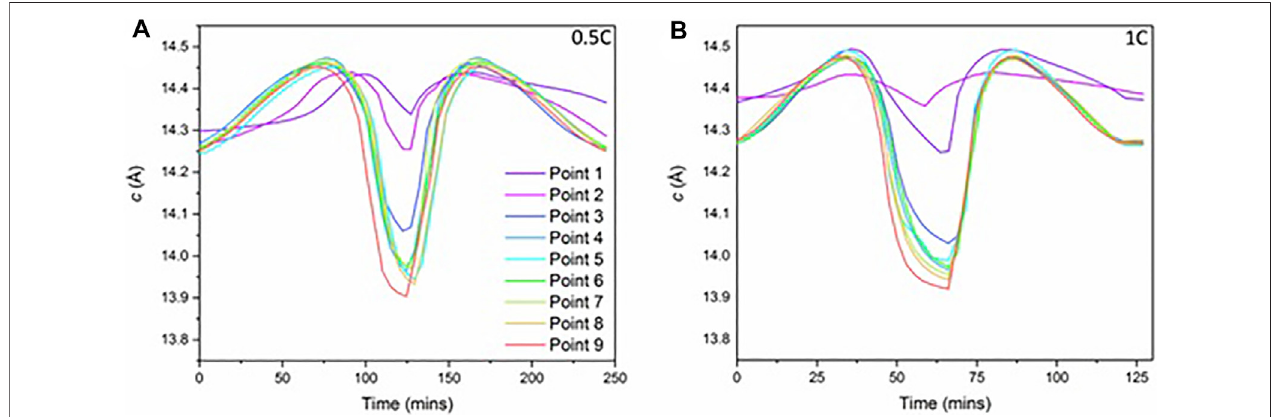
FIGURE 5 | The c-parameter values as a function of time for each of the nine points for (A) 0.5 C and (B) 1 C. The cell was cycled to 4.2 V.